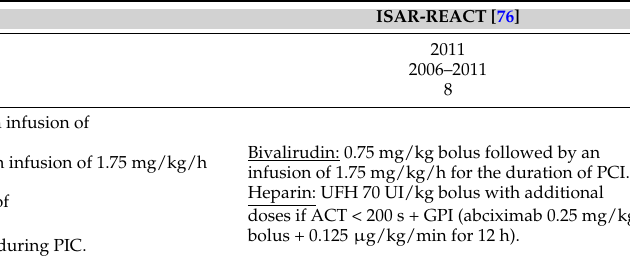
Table 2. Randomised clinical trials of bivalirudin in patients with